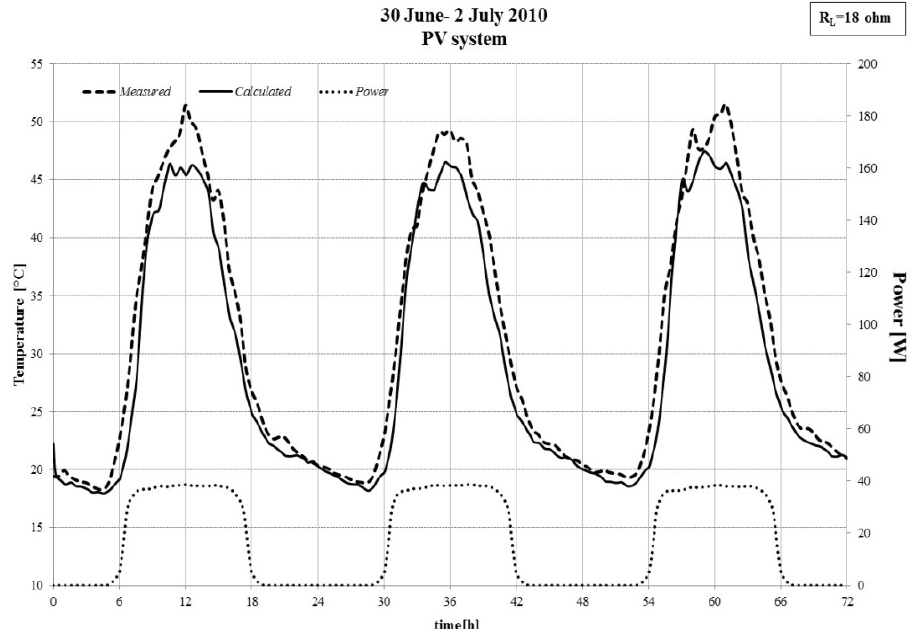
Figure 13. Temperature trend of the measured and simulated PV system, together with measured power output, in Palermo, 30 June–2 July 2010.